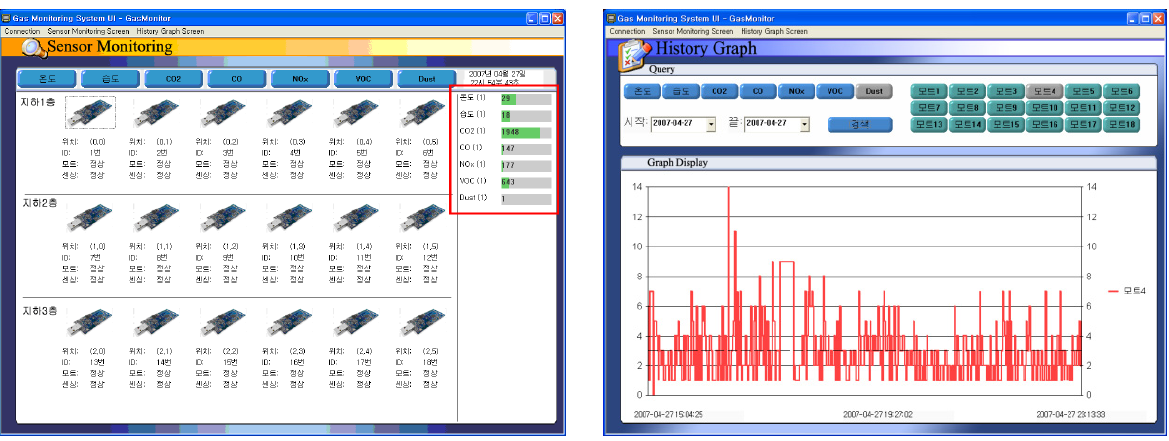
Figure 5 . Screenshots of the host PC